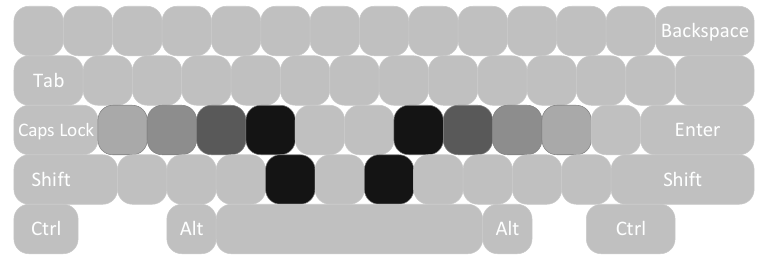
Electronics 2021 , 10 , x FOR PEER REVIEW Figure 3. Alternative keyboard arrangement of ORK+ type with 10 keys. Figure 3. Alternative keyboard arrangement of ORK+ type with 10 keys.